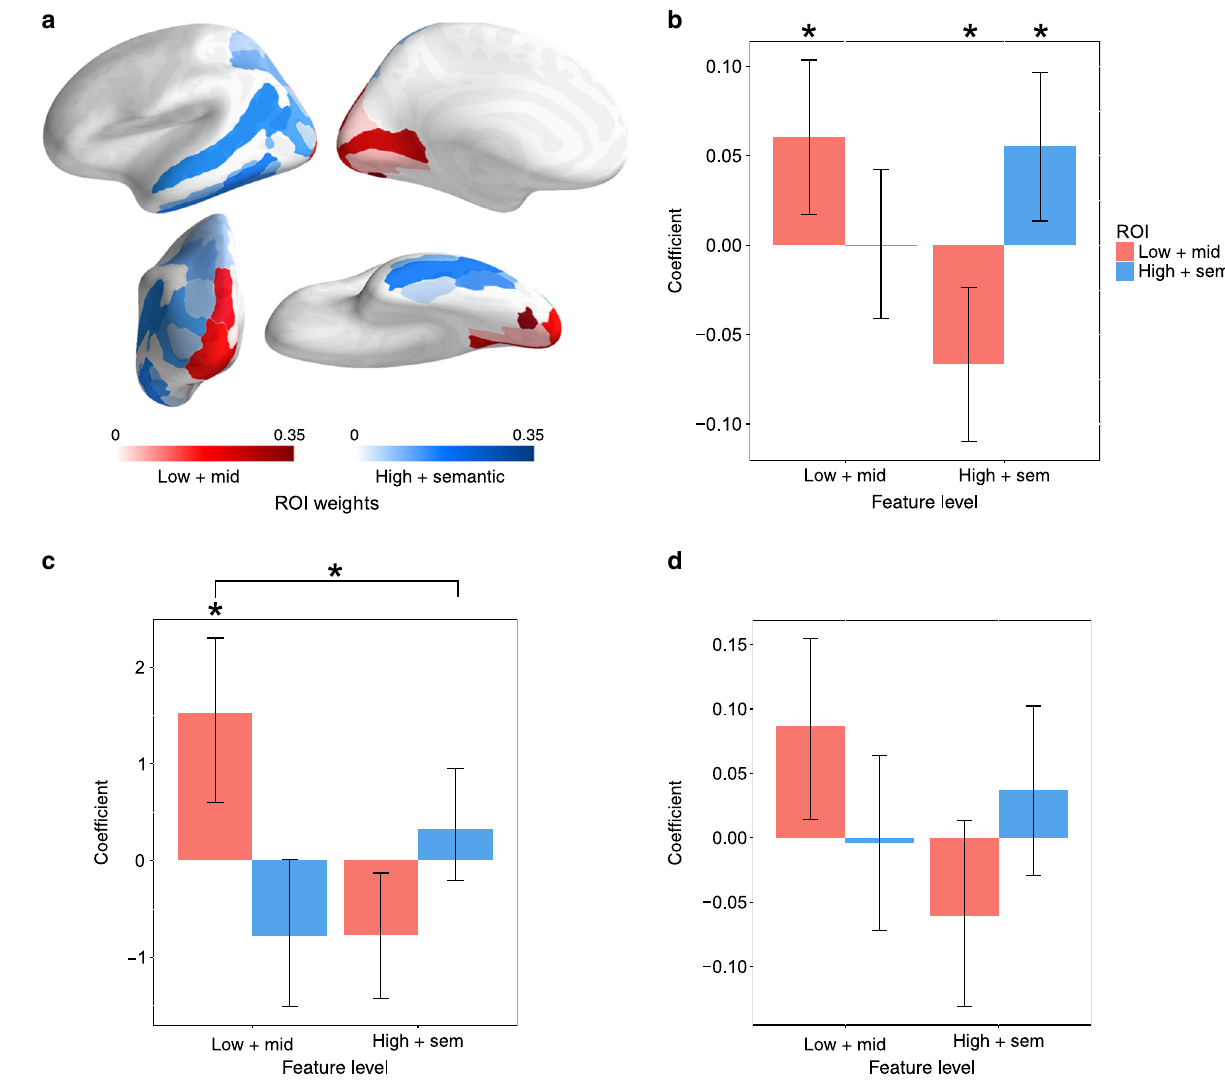
Fig. 5 Correlations between feature-speci fi c neural reactivation, vividness, and recognition accuracy. a ROI weights combining the low- and mid-level and high- and semantic-level ROIs. b Within-subject partial regression coef fi cients measuring the relation between neural reactivation during recall and vividness for all combinations of feature-level and ROI. c Between-subject partial regression coef fi cients measuring the relation between neural reactivation and recognition accuracy (during the Old/New task) for all combinations of feature-level and ROI. d Within-subject partial regression coef fi cients measuring the relation between neural reactivation and recognition accuracy for the 13 subjects with the highest average “ new ” /lure trial accuracy. The error bars are 95% CIs; *indicates p < 0.05, two-tailed bootstrap, FDR corrected over the four coef fi